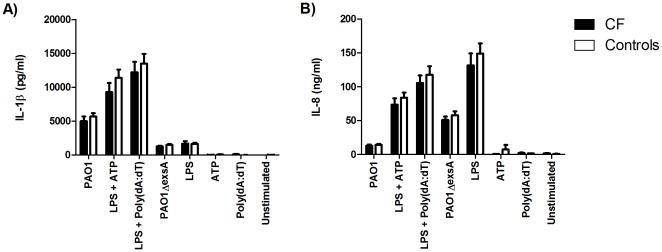
PBMCs from CF patients do not produce increased amounts of IL-1β.PBMCs from CF patients (n = 17–20) and healthy controls (n = 15–19) were primed with LPS (10 ng/ml) overnight and stimulated with P. aeruginosa PAO1 (MOI = 1), P. aeruginosa PAO1 lacking exsA (MOI = 1), ATP (5 mM), or Poly(dA:dT) (1 µg/ml) for 24 hours. P. aeruginosa lacking exsA was used as a type III secretion control in comparison with wild-type P. aeruginosa. Supernatants were assayed for (A) IL-1β and (B) IL-8.